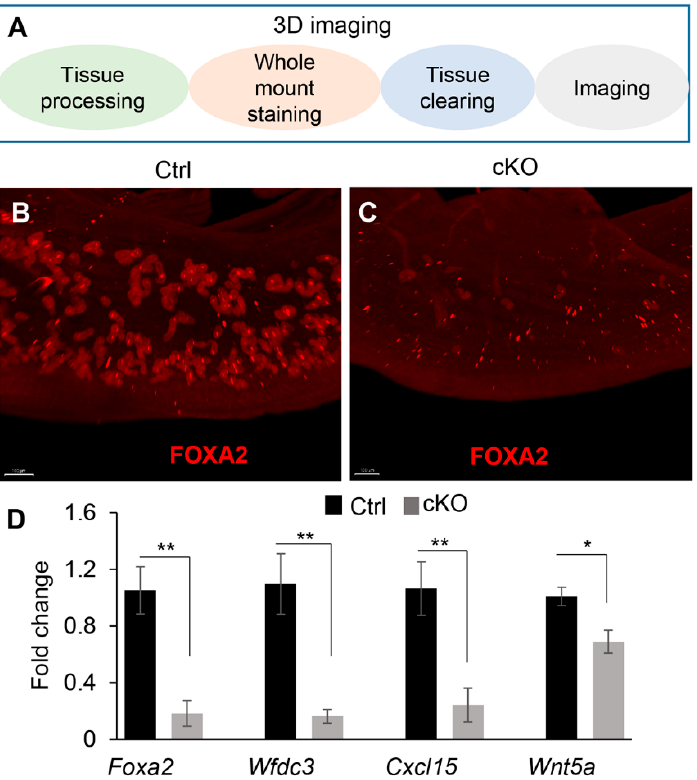
Figure 2. Tridimensional imaging showing defective uterine gland development in Ezh2 Amhr2 -Cre cKO mice. ( A ) Primary steps for 3D imaging analysis. ( B , C ) Tridimensional view of uteri from control and Ezh2 Amhr2 -Cre cKO mice by whole-mount staining of FOXA2 at 1 month of age. Three independent samples for each genotype were examined. Scale bar = 200 µ m. ( D ) qRT-PCR analysis of uterine gland- and adenogenesis-associate genes using uteri from 1-month-old control and Ezh2 Amhr2 ‐ Cre cKO mice. n = 5 for each genotype. Data are mean ± s.e.m. * p < 0.05 and ** p < 0.01.